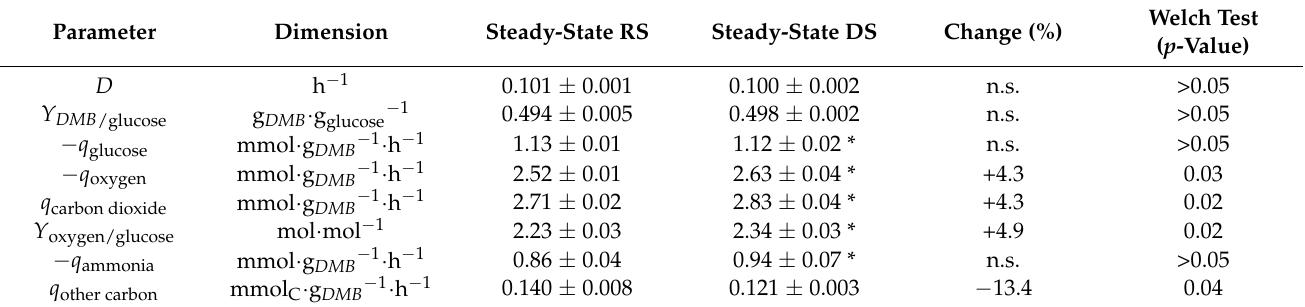
Table 2. Yeast kinetics at the steady states RS (reference) and DS (after dynamic perturbation).